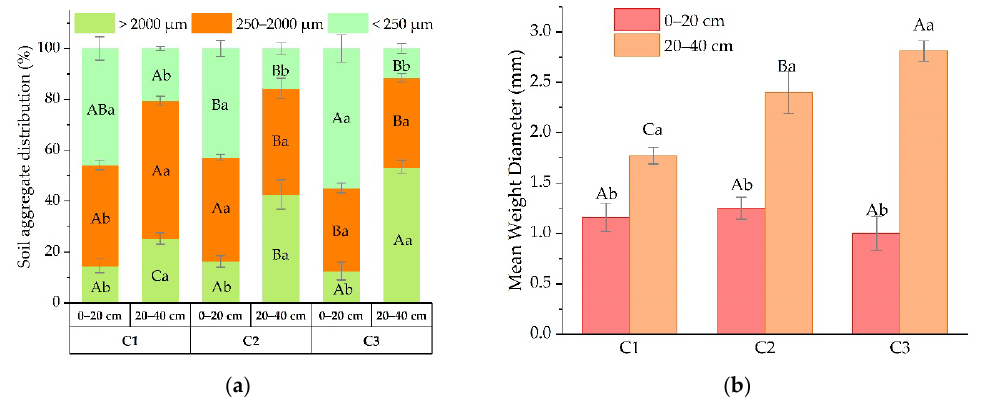
Figure 2. ( a ) Soil aggregate distribution; ( b ) mean weight diameter (MWD) in depths of 0–20 cm and 20–40 cm (n = 4). Capital letters indicate significant differences among plots, while lower letters indicate significant difference between 0–20 cm and 20–40 cm soil depths ( p < 0.05). C1, C2, and C3 were the sample plots in the study.